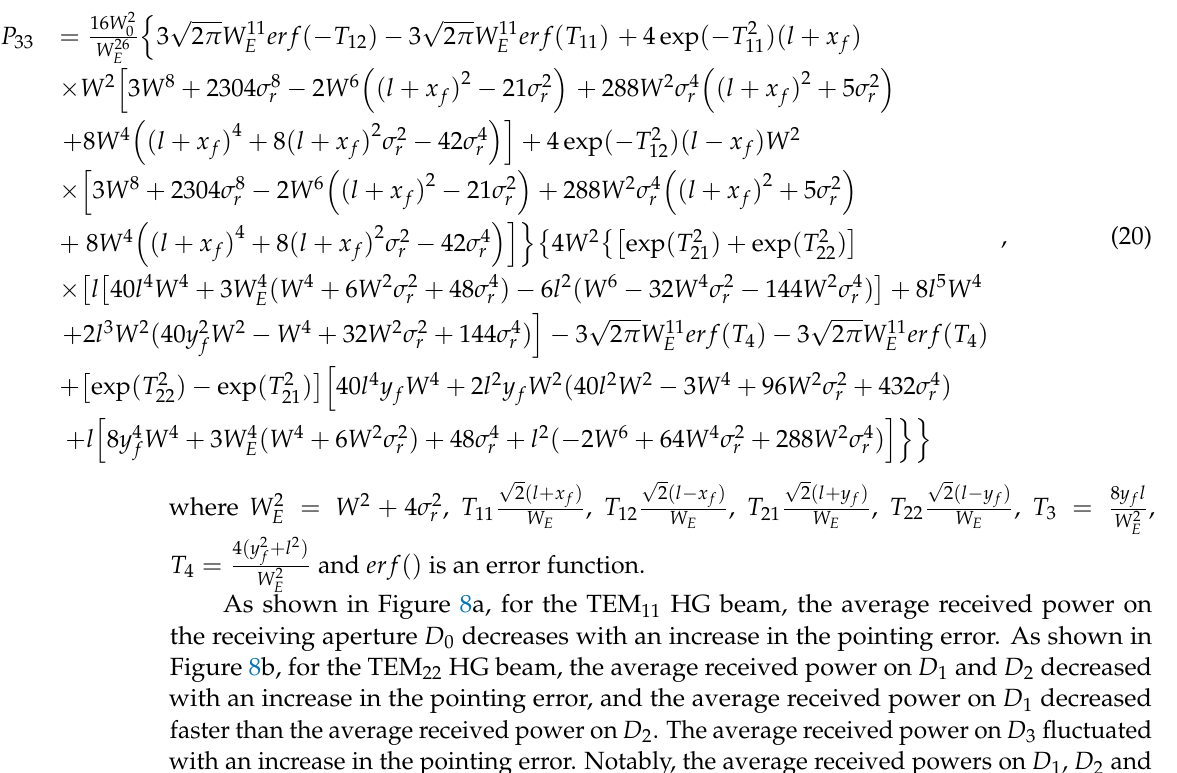
( c ) Figure 9. Average irradiance of TEM 22 HG beam when r σ = 12.67 μ rad. ( a ) A 3D diagram, ( b ) a vertical diagram and ( c ) a cross-section along the x axis.